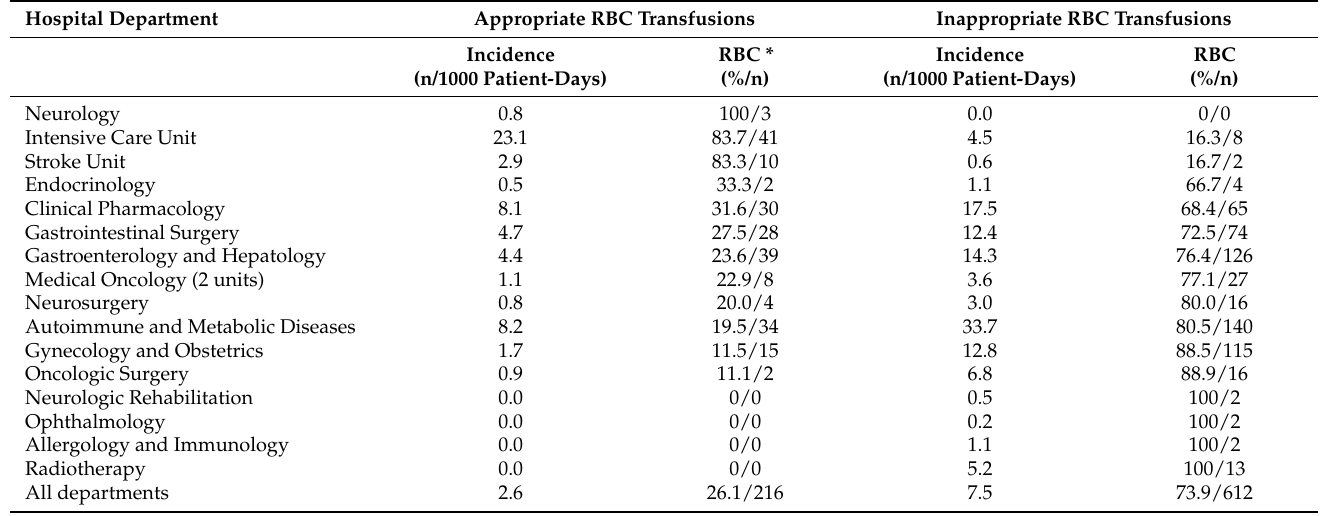
Table 4. Incidence, number, and volume of appropriate and inappropriate red blood cell transfusions